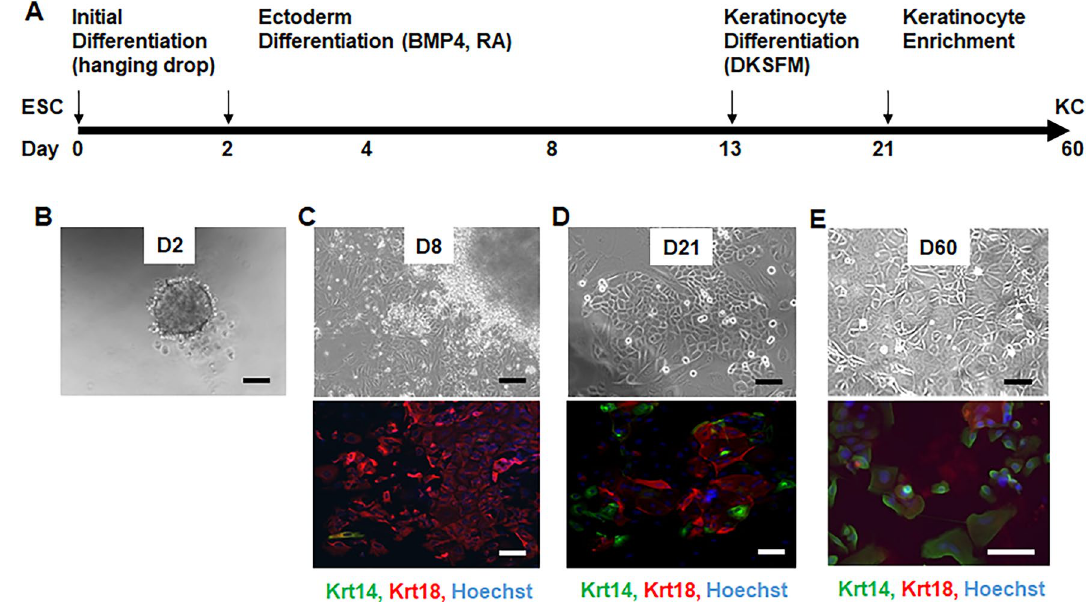
Figure 1. Differentiation of mESCs to keratinocytes in vitro. ( A ) Scheme of in vitro mESC to keratinocyte differentiation. Representative brightfield and immunofluorescent staining images of ( B ) cell aggregates and EBs on Day 2 (D2), ( C ) attached EBs grown in presence of RA and BMP4 for 6 days (D8) with cells outgrown from the EBs expressing Krt 18 and few cells at the most outer layer started to express Krt 14, ( D ) Passaged cells